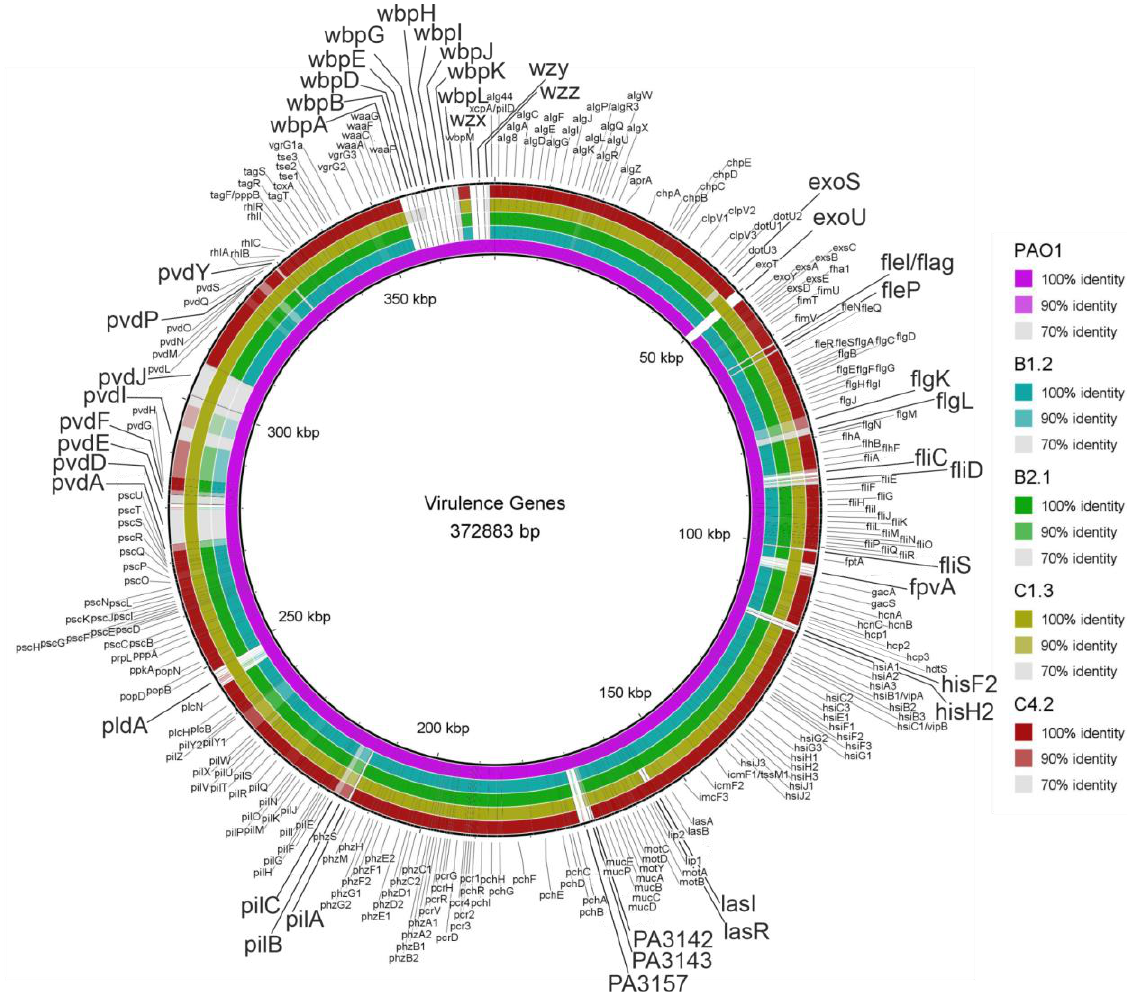
Figure 6. A circular illustration of the comparison of 285 virulence- and biofilm-associated genes among the WM isolates of P. aeruginosa . BLAST Ring Image Generator (BRIG) was used to create the circular map. All genes were taken from the reference strain PAO1, except for exoU which was taken from the reference strain PA14. Genes with identity scores less than 90% have bigger labels.